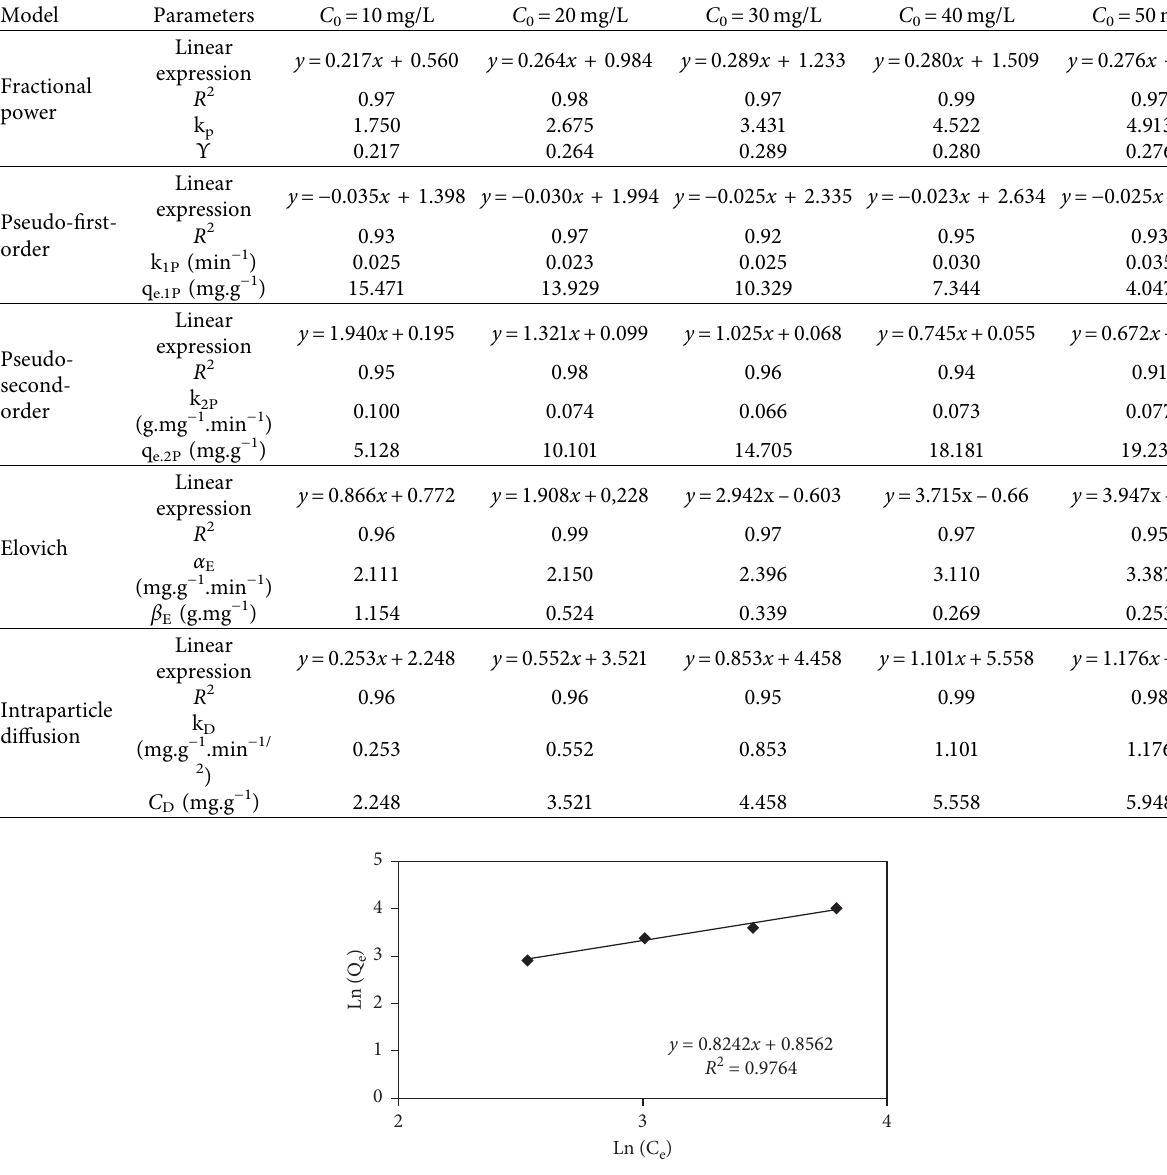
Figure 15: Linearity of Freundlich